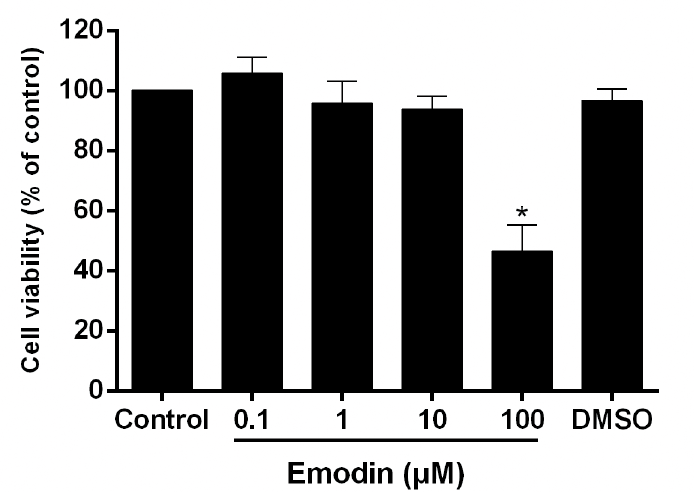
Fig 1. Effect of emodin on the viability of VSMCs. The cells were incubated with the different concentrations of emodin for 24 h. Then, the cell viability was assayed by the MTT method. DMSO (0.1%) was used as solvent control. Results from three independent experiments were expressed as mean ± S.E.M. * P < 0.05 vs .